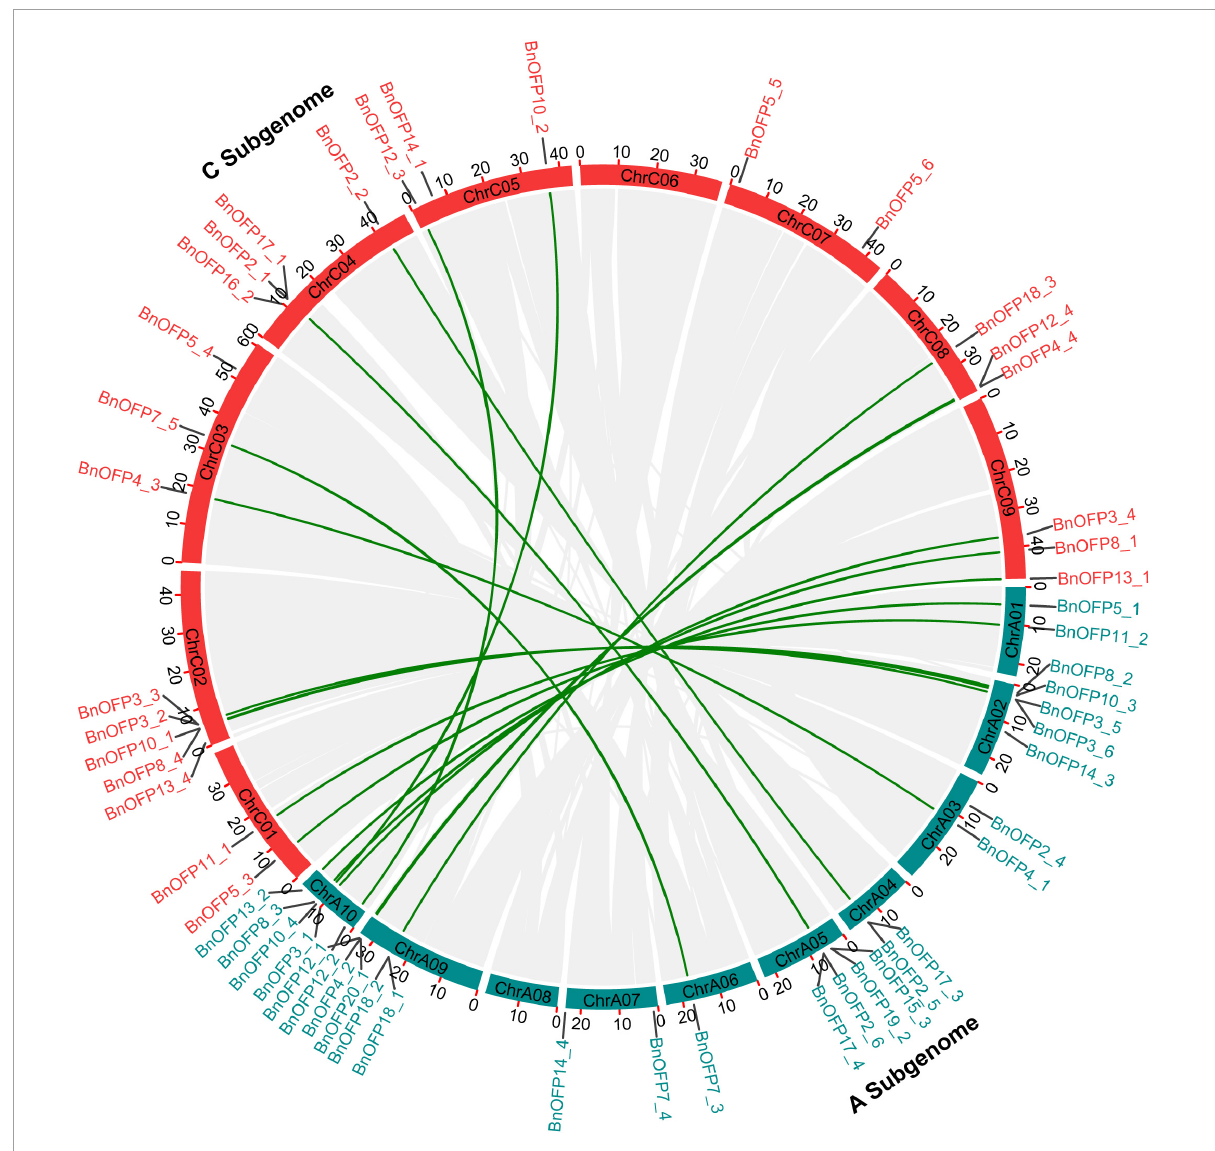
FIGURE3 Syntenic relationship between Brassica napus A and C sub-genome. Chromosomes including BnOFP members of two sub-genomes are shown in different color. Gray lines in circle represent the syntenic genes or blocks, and dark green lines represent the syntenic genes in BnOFPs